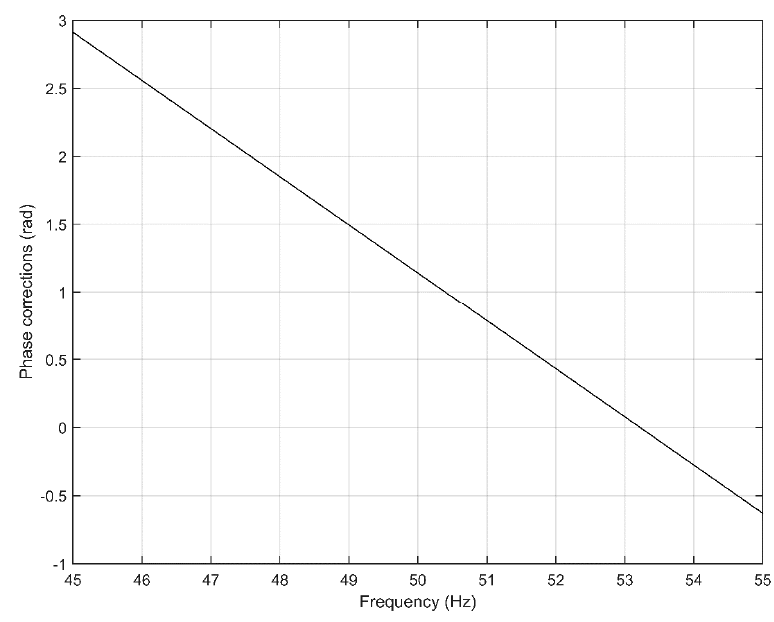
Figure 2. The correction of a phase shift introduced by the FIR filter as a function of the input signal frequency.